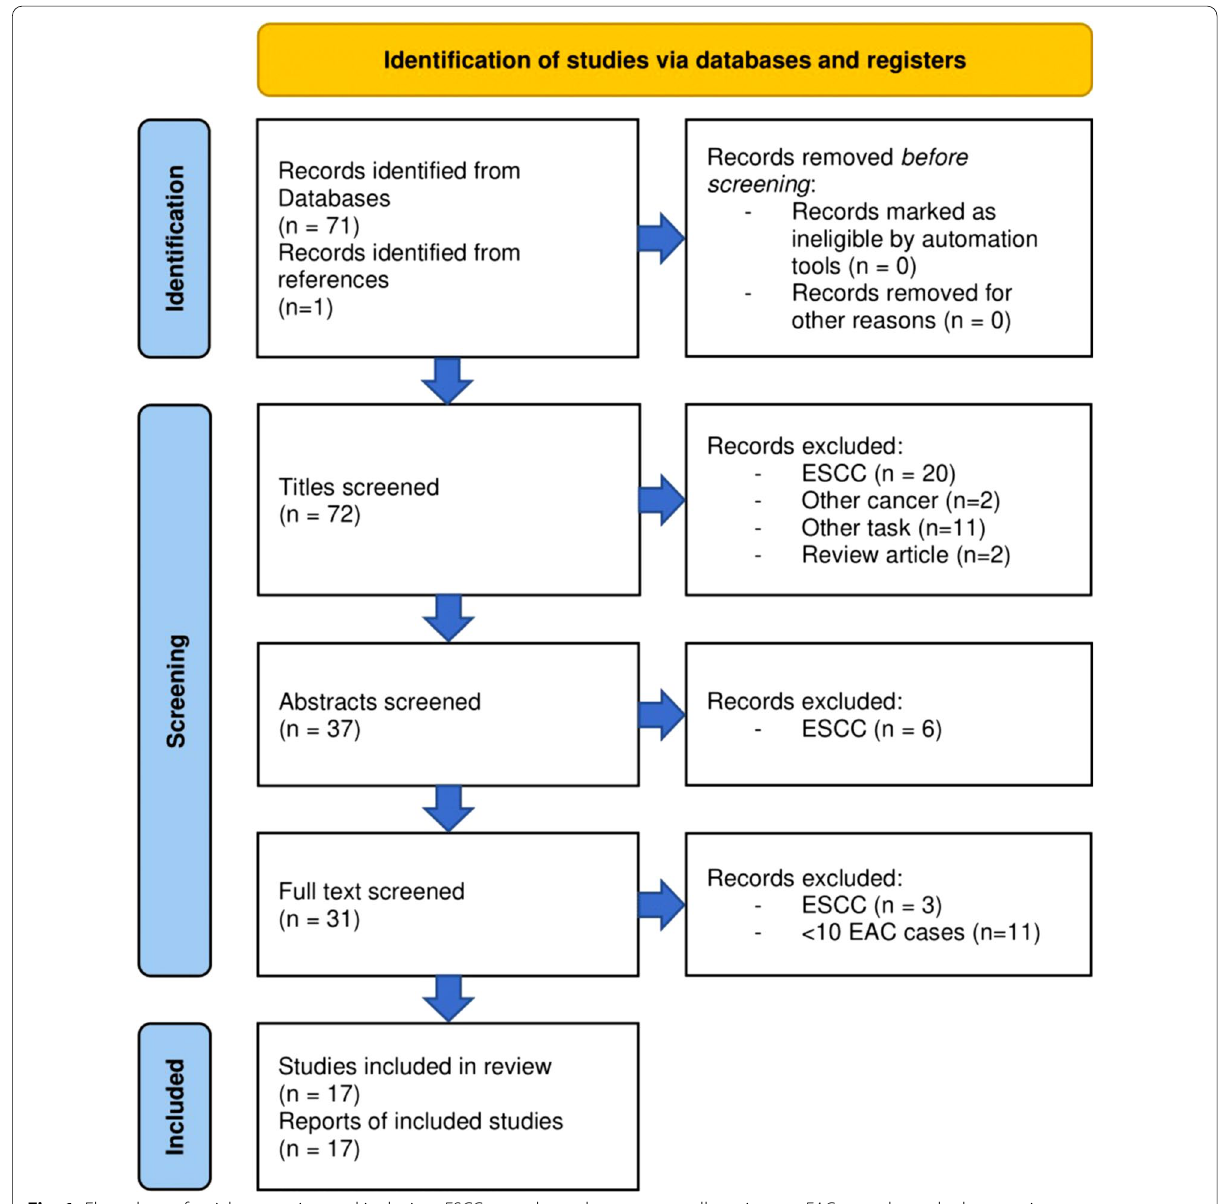
Fig. 1 Flow chart of article screening and inclusion. ESCC oesophageal squamous cell carcinoma, EAC oesophageal